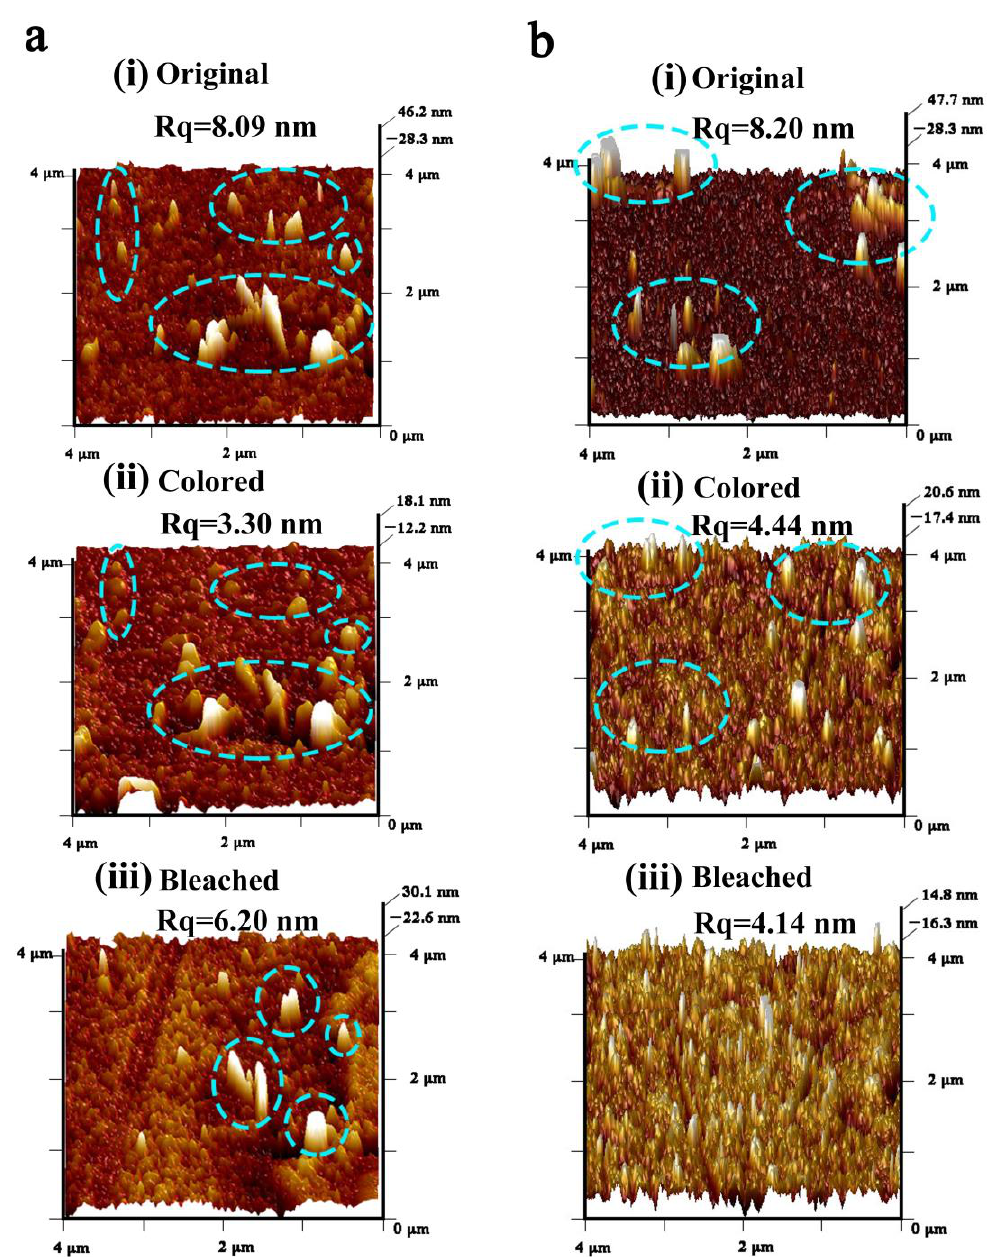
Figure 5. AFM morphology evolution of the WO 3 films during one-step Li ion insertion and